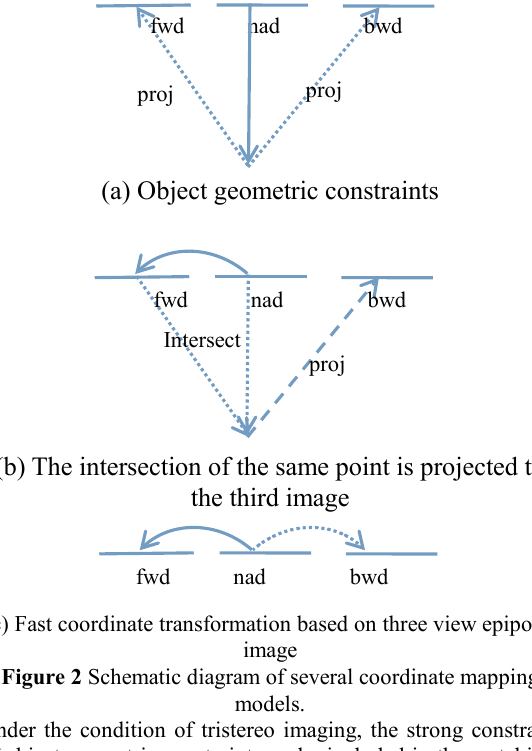
Figure 2 Schematic diagram of several coordinate mapping